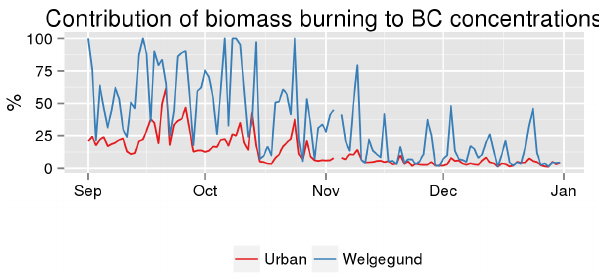
Figure 12. Estimated contribution of biomass burning emissions to BC concentrations in the Johannesburg-Pretoria urban area and at